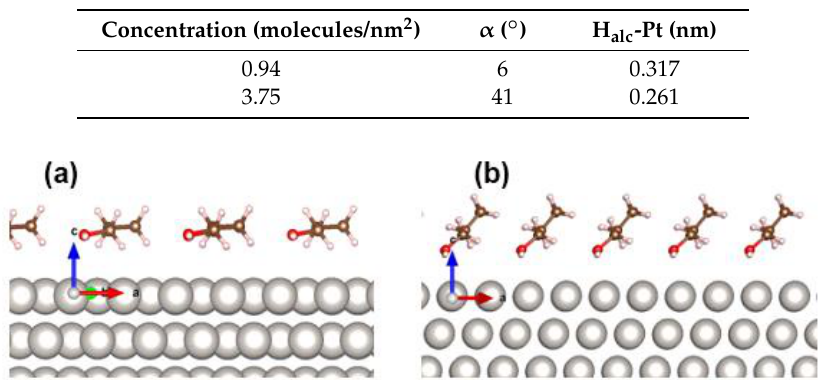
Table 1. 1-Propanol molecule orientation as angle of C–C bonds relative to surface normal, and nearest surface–molecule distance for different concentrations of molecules on Pt(111) surface [21].